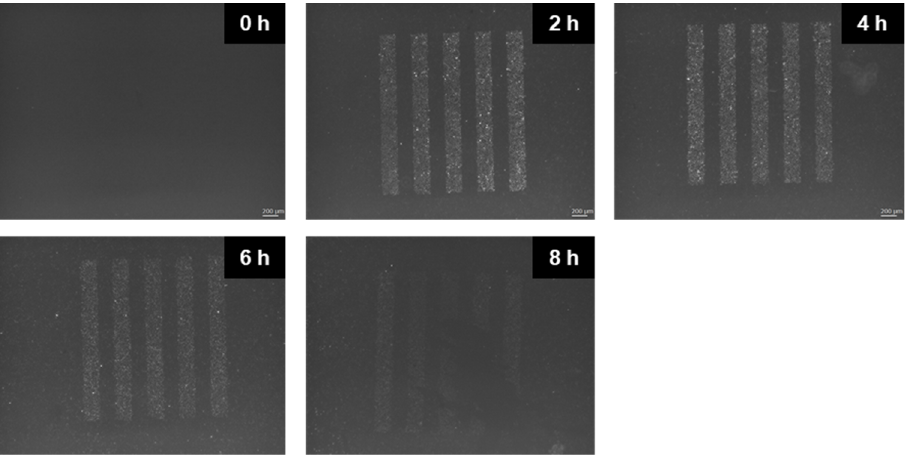
Figure 3. γ -H2AX-stained images of HeLa–FUCCI cells following exposure to 200 μ m-slit X-ray beams. Cells were irradiated using 200 μ m-slit X-ray beams. Representative γ -H2AX-stained images of FUCCI cells 0, 2, 4, 6, and 8 h after irradiation. The distribution of immune-stained γ -H2AX in the sample was a good approximation of the shape of the 200 μ m-slit irradiation patterns. Scale bar, 200 μ m.